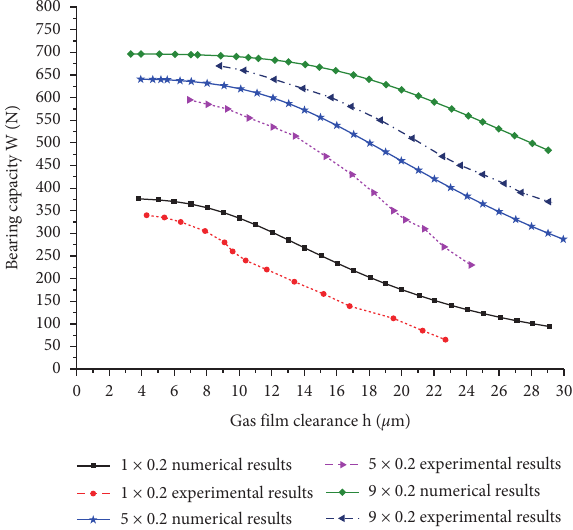
Figure 14: Curves of theoretical and experimental results of bearing capacity. Figure 13: Diagram of the physical device for the test